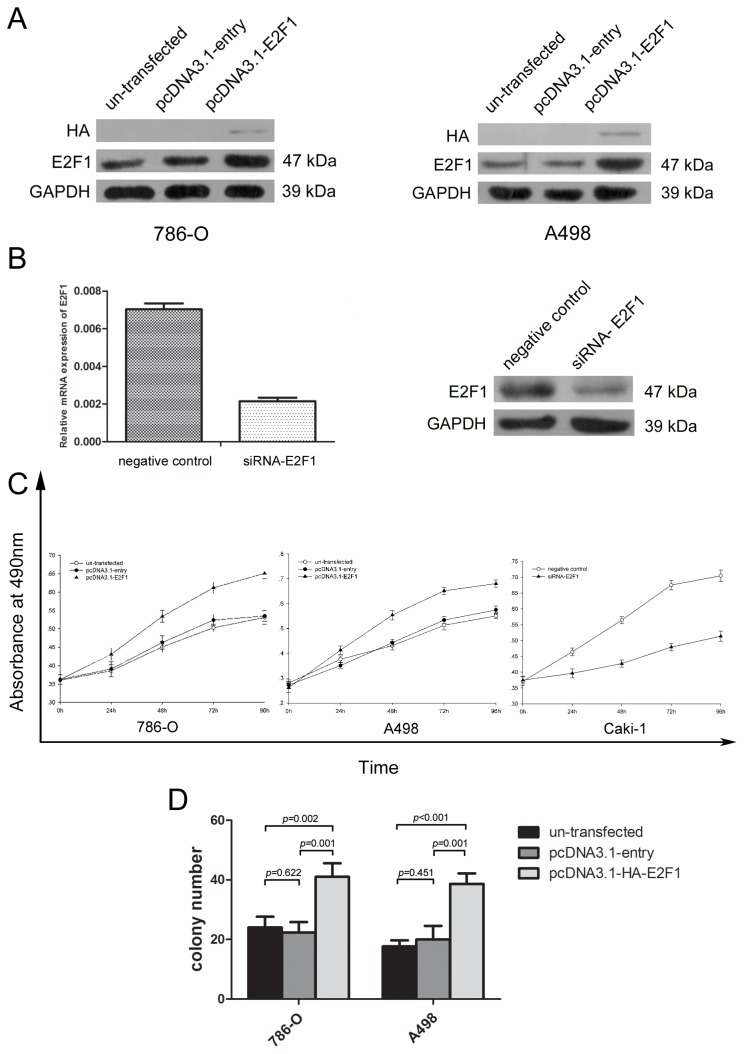
Overexpression of E2F1 led to the proliferation of the tumor cells in vitro.(A) Alteration in the protein levels of the 786–0 and A498 cells 48 hours after transfection with entry or E2F1 plasmid (B). The expression levels of E2F1 knockdown in Caki-1 were determined by real-time PCR and western blot analysis. (C) MTS assay showed E2F1 overexpression accelerated the proliferation velocity in 786-O and A498 cells and knockdown of E2F1 in Caki-1 decreased the proliferation. Each experiment was performed in triplicate. (D) Effect of E2F1 in colony formation of 786-O and A498 cells. The number of foci >100 cells was counted after 14 days. Each experiment was performed in triplicate.